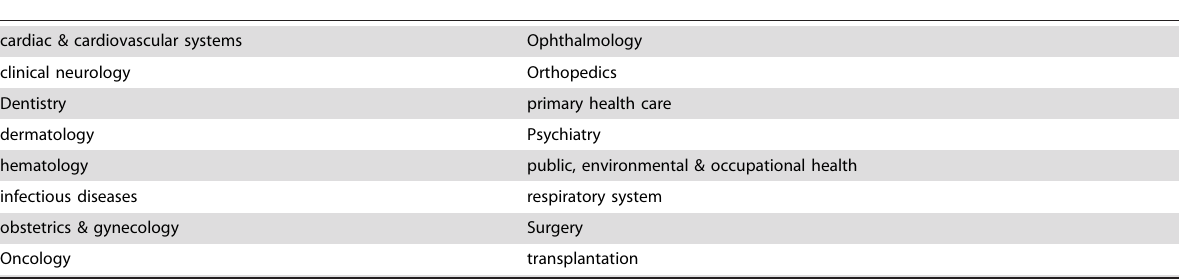
Table 1. The 16 clinical fields included in the